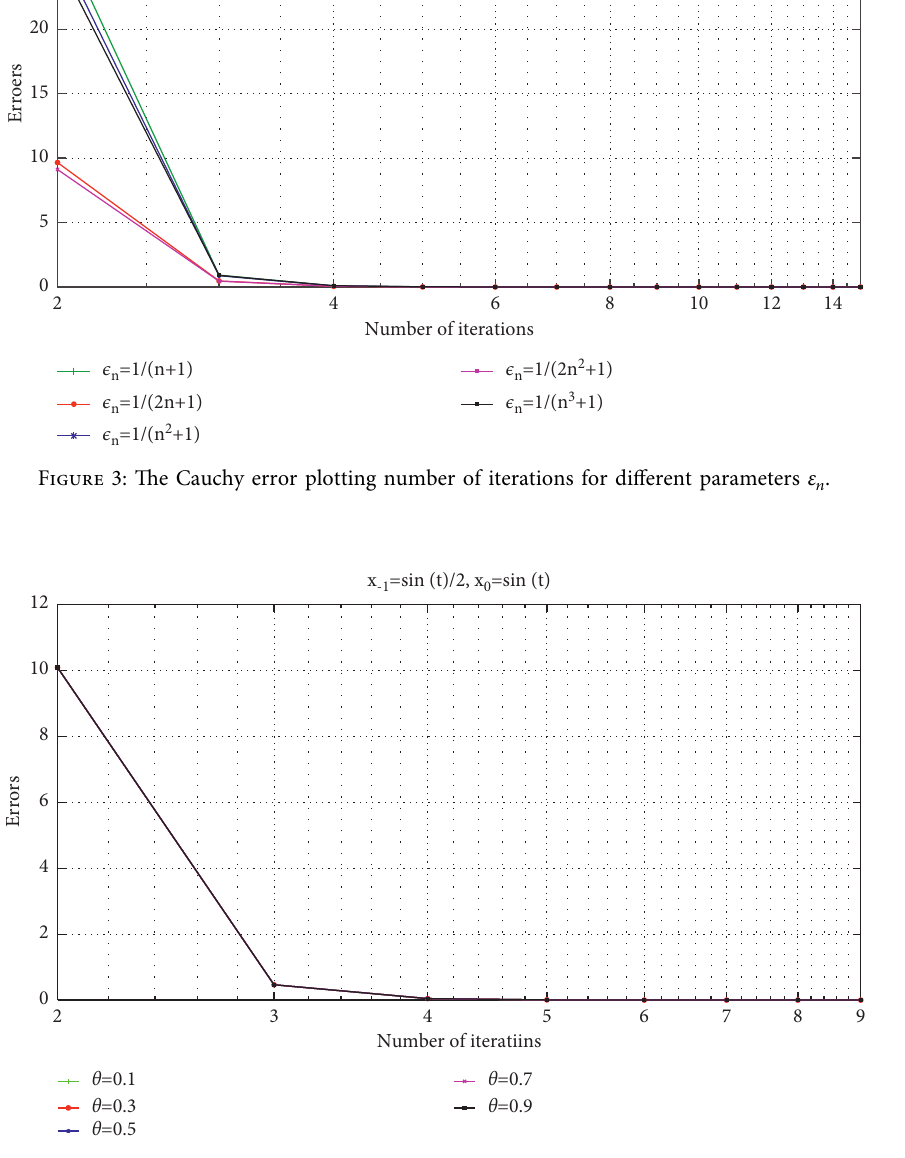
Figure 4: The Cauchy error plotting number of iterations for different parameters θ